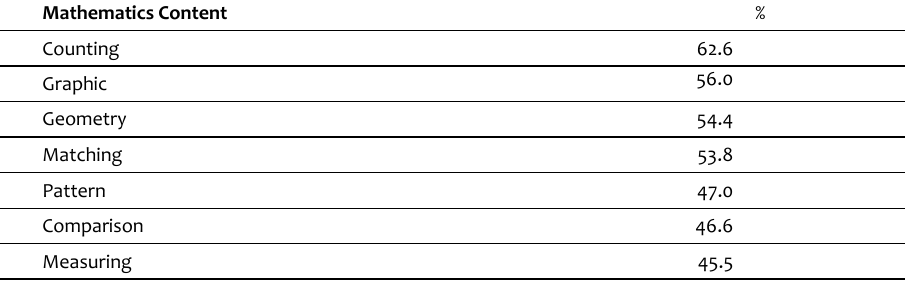
Table 2. Response distribution of teachers’ mathematics content and process skills Mathematics